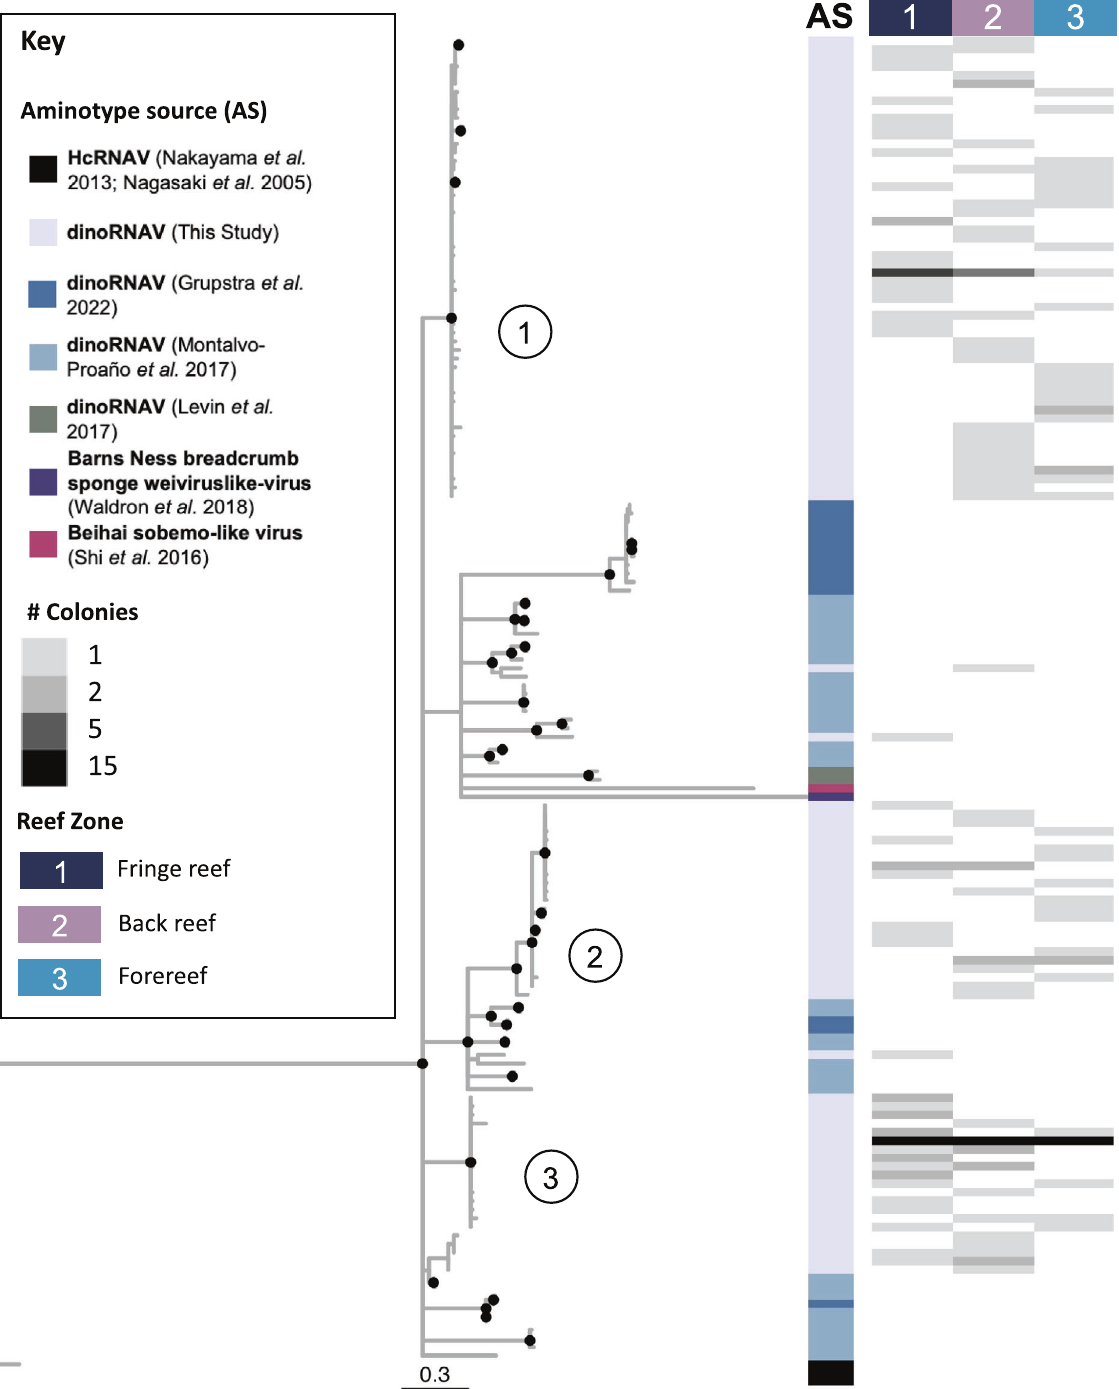
Fig. 3 Maximum likelihood tree of dinoRNAV major capsid protein ( mcp ) unique amino acid sequences ( ‘ aminotypes ’ ) from Porites lobata-Cladocopium C15 holobionts in this study as well as previously reported dinoRNAV mcp sequences and related viral sequences. A maximum likelihood phylogeny with 500 bootstrap iterations was generated using dinoRNAV mcp aminotype sequences generated from Porites lobata-Cladocopium C15 holobionts from coral reefs of Moorea, French Polynesia (South Paci fi c) in this study, as well as previously reported mcp sequences from the Great Barrier Reef [30], Moorea [29], and related viral sequences such as the Beihai sobemo-like virus and the Barns Ness breadcrumb sponge weiviruslike-virus [44, 54]. This tree was outgroup rooted by the longest branch, Heterocapsa circularisquama RNA virus (HcRNAV, [52, 53]). Colors in the vertical bar (Aminotype Source, AS) indicate the origin of a given sequence. Branches with less than 50% bootstrap support were collapsed; branches with bootstrap support >70% are depicted with a black dot. Only aminotypes that were present in >10% relative abundance in at least one sample are included in the phylogeny. Gray tone heat maps indicate the number of colonies from which each aminotype was detected, separated by reef zone (rightmost columns 1 – 3). Circled numbers reference the three largest clades of dinoRNAV aminotypes from this